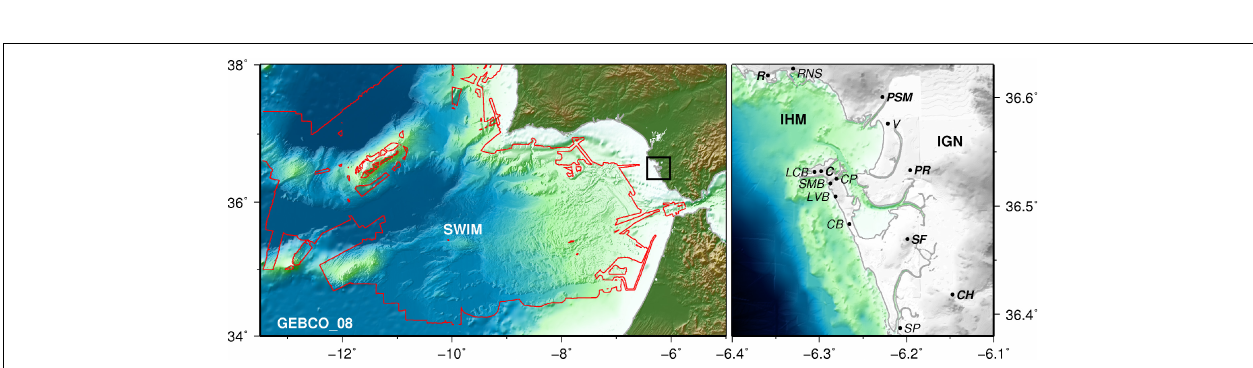
FIGURE 9 | Topo-bathymetric grids. GEBCO data, SWIM: Zitellini et al. (2009) bathymetric data (The red line is the limit of the high resolution SWIM bathymetry), IHM: Instituto Hidrográfico de la Marina (Navy Hydrographic Institute) data (the black square is the limit of the high resolution local bathymetry IHM), IGN: Instituto Geográfico Nacional (National Geographic Institute) data. Labels in italic font type show the locations commented in the text: R, Rota; RNS, Rota Naval Station; PSM, Puerto de Santa María; V, Valdelagrana; C, Cádiz; CP, Cádiz Port; LCB, La Caleta Beach; SMB, Santa María Beach; LVB, La Victoria Beach; CB, Cortadura Beach; PR, Puerto Real; SF, San Fernando; CH, Chiclana; SP, Sancti Petri.